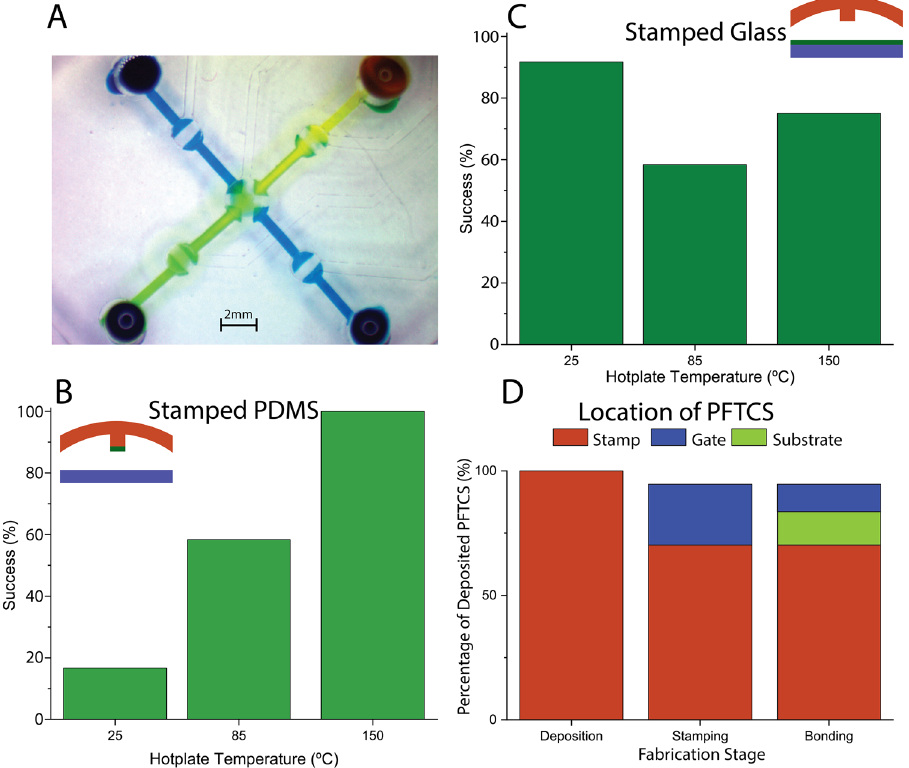
Figure 4. Characterization of transfer of PFTCS from a PDMS stamp to different substrates. ( A ) A simple 5-microvalve chip design. (B-C) The success rate of PFTCS transferred from a PDMS stamp to PDMS features and to glass, respectively. The inset images in ( B ) and ( C ) show the location of the PFTCS (green) with respect to the PDMS (red) and glass (blue). ( D ) PFTCS thickness tracked throughout the fabrication process of a PDMS gate stamped with PFTCS under the optimized fabrication parameters. All results are from 10 of the 5-microvalve chips shown in ( A